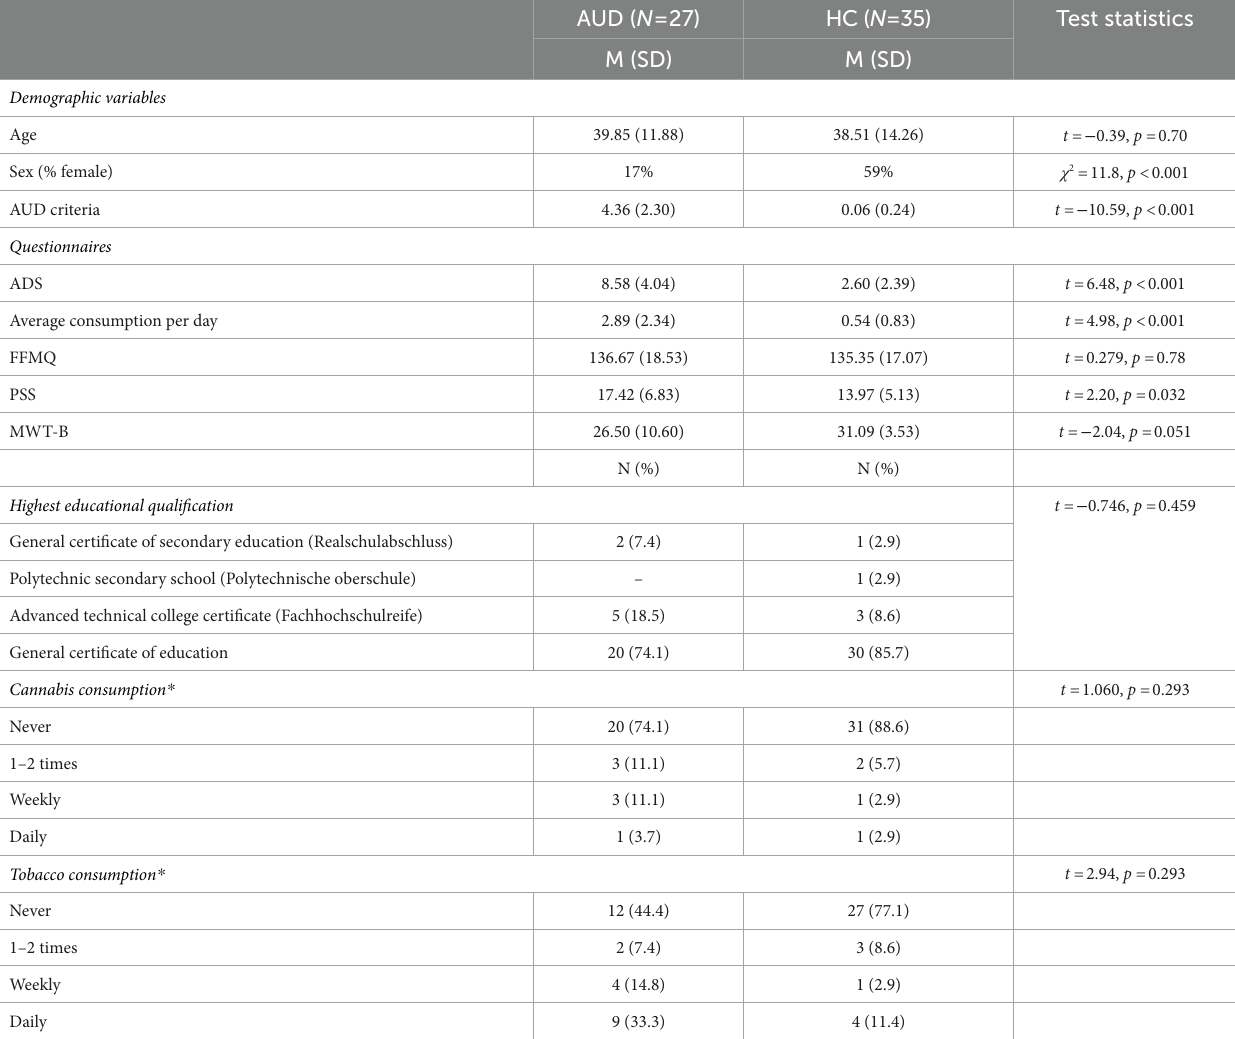
TABLE 1 Sample characteristics of AUD and HC